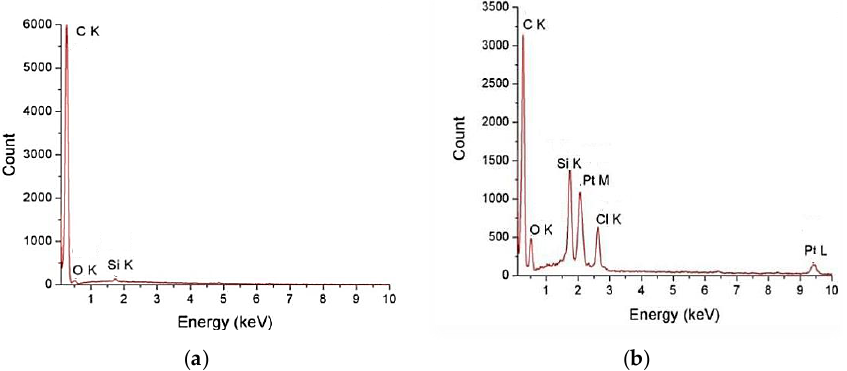
Figure 3. EDX spectra for: ( a ) MWCNT-COOH and ( b ) MWCNT-COOH-CDDP.